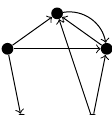
Figure 5. A digraph for which using apparent pairs to compute the homology of the directed flag complex gives the wrong